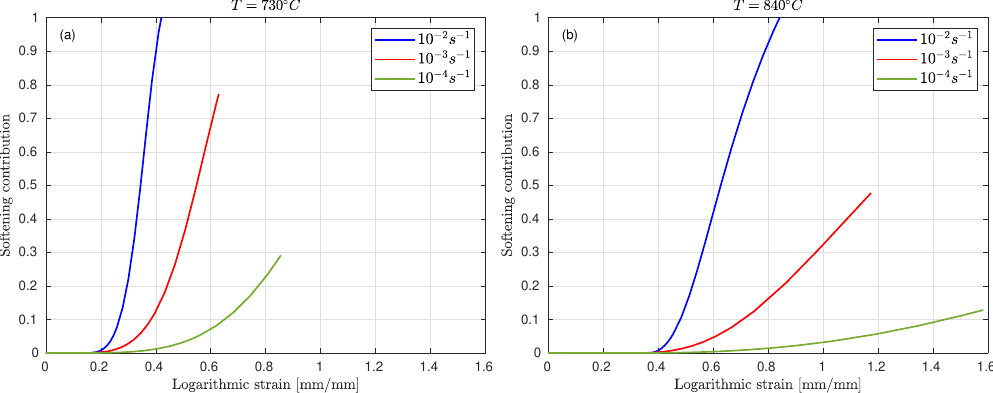
Figure 10. Normalised softening mechanism estimated from variable S at T = 730 ◦ C ( a ) and T = 840 ◦ C ( b